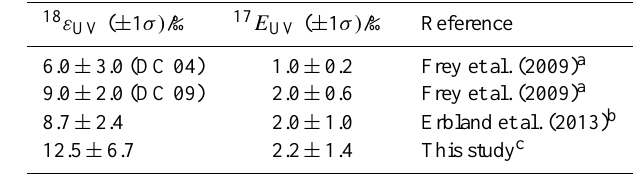
Table 3. Apparent isotopic fractionations ( 15 ε app ) observed in pre- vious studies compared to the results obtained here.